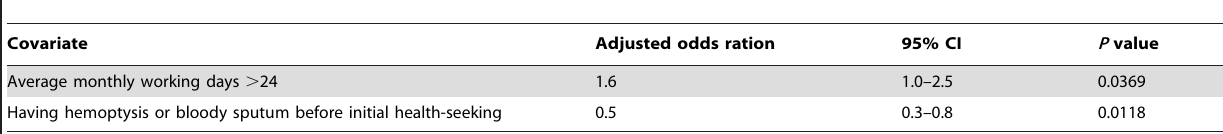
Table 3. Multivariate analysis of factors associated with delayed IHS.